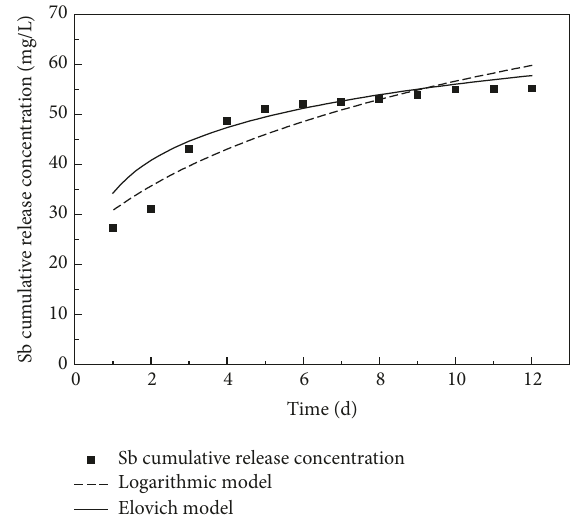
Figure 11: Data fitting of the Sb release with Elovich